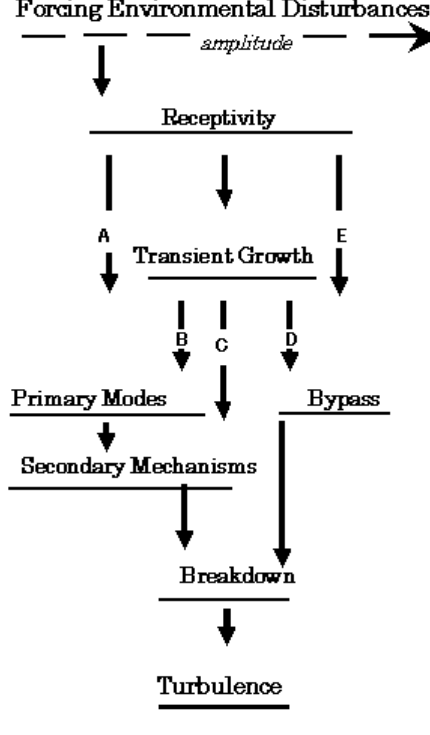
Fig. 1 The paths to turbulence